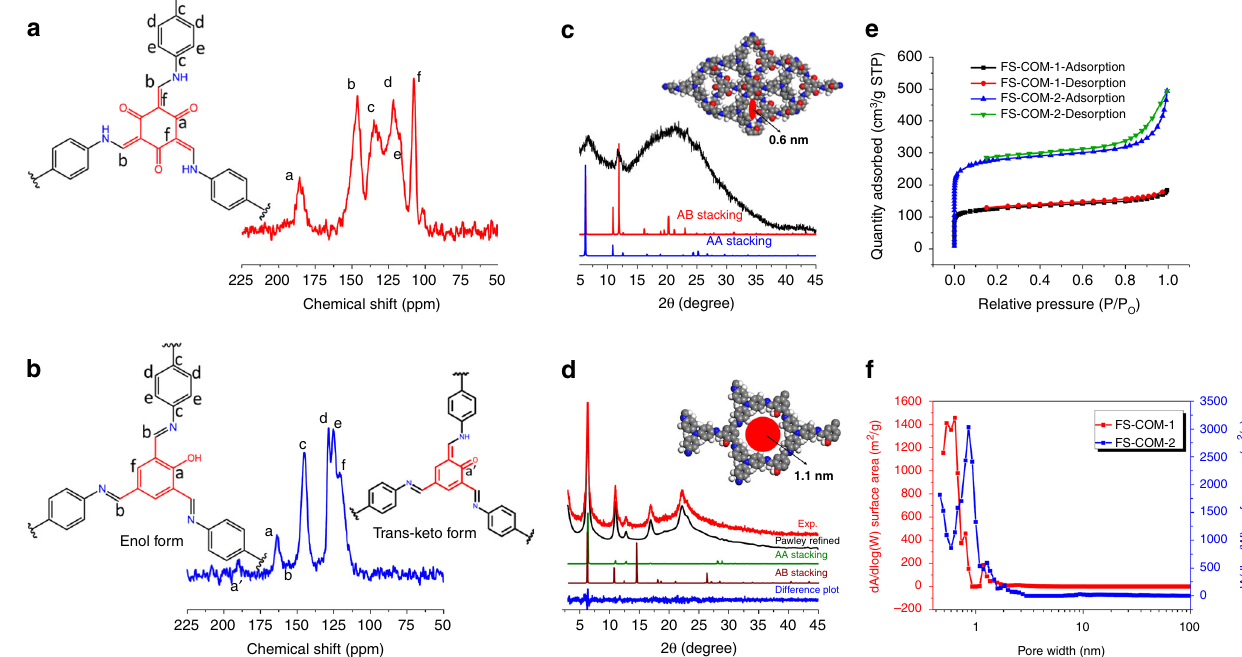
Fig. 3 Structural characterizations. 13C solid-state NMR spectra of FS-COM-1 ( a ) and FS-COM-2 ( b ). c PXRD patterns of FS-COM-1 comparison between the experimental and the simulated patterns for eclipsed AA stacking mode and AB stacking mode. d PXRD patterns of FS-COM-2 comparison between the experimental and Pawley re fi ned pro fi les, the simulated patterns for eclipsed AA stacking mode, AB stacking mode, and the re fi nement differences plot. e N2 adsorption isotherms of FS-COM-1 and FS-COM-2. f Pore size distribution of FS-COM-1 and FS-COM-2. The red, blue, gray, and white spheres represent O, N, C, and H atoms,